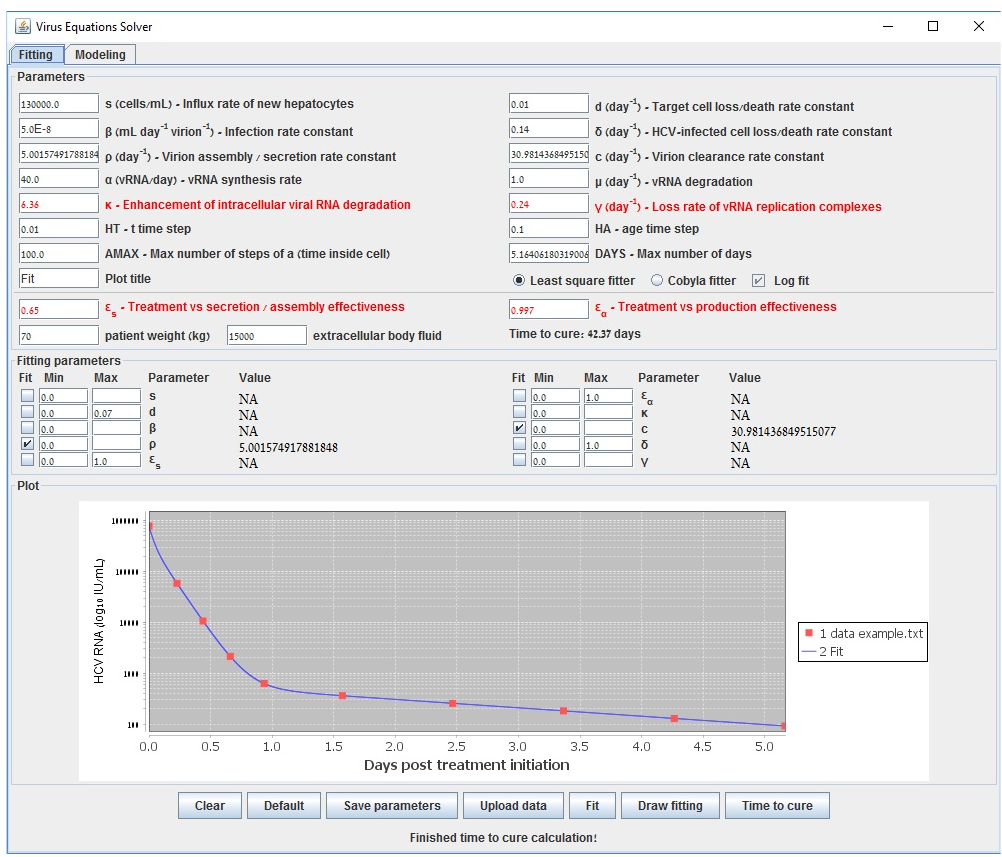
Figure A8. Fitting the parameters c and ρ of the multiscale model to generated data points using the LSF